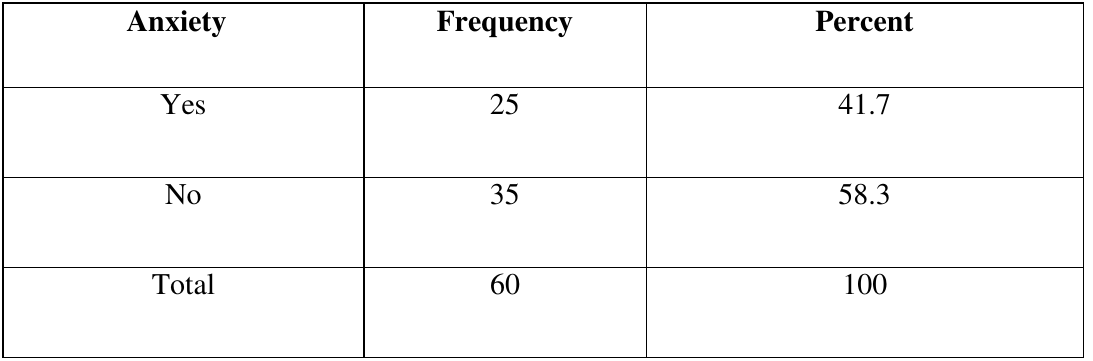
Table: 1. Distribution of Respondents According to Presence of Anxiety after weighted